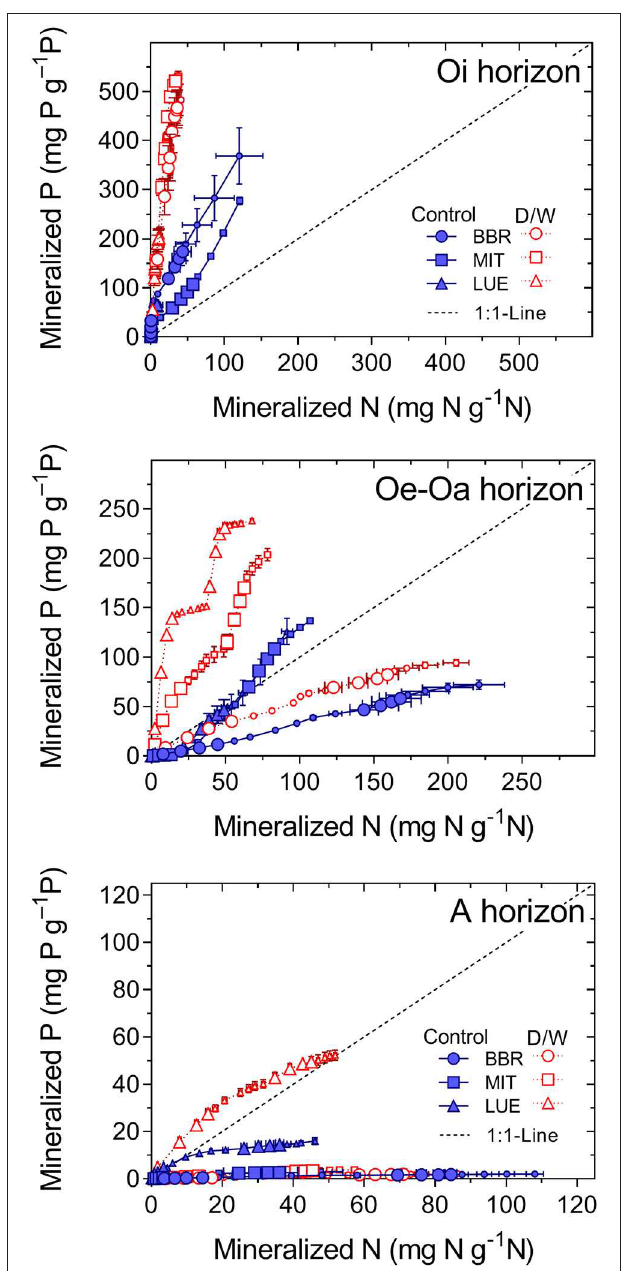
FIGURE 3 | Net P mineralization related to net N mineralization, each normalized to the nutrient contents of the soil. Means and standard errors of four replicates. The D/W-treatment consisted of one short, harsh initial drying and a second moderate, 1 month-long drying.